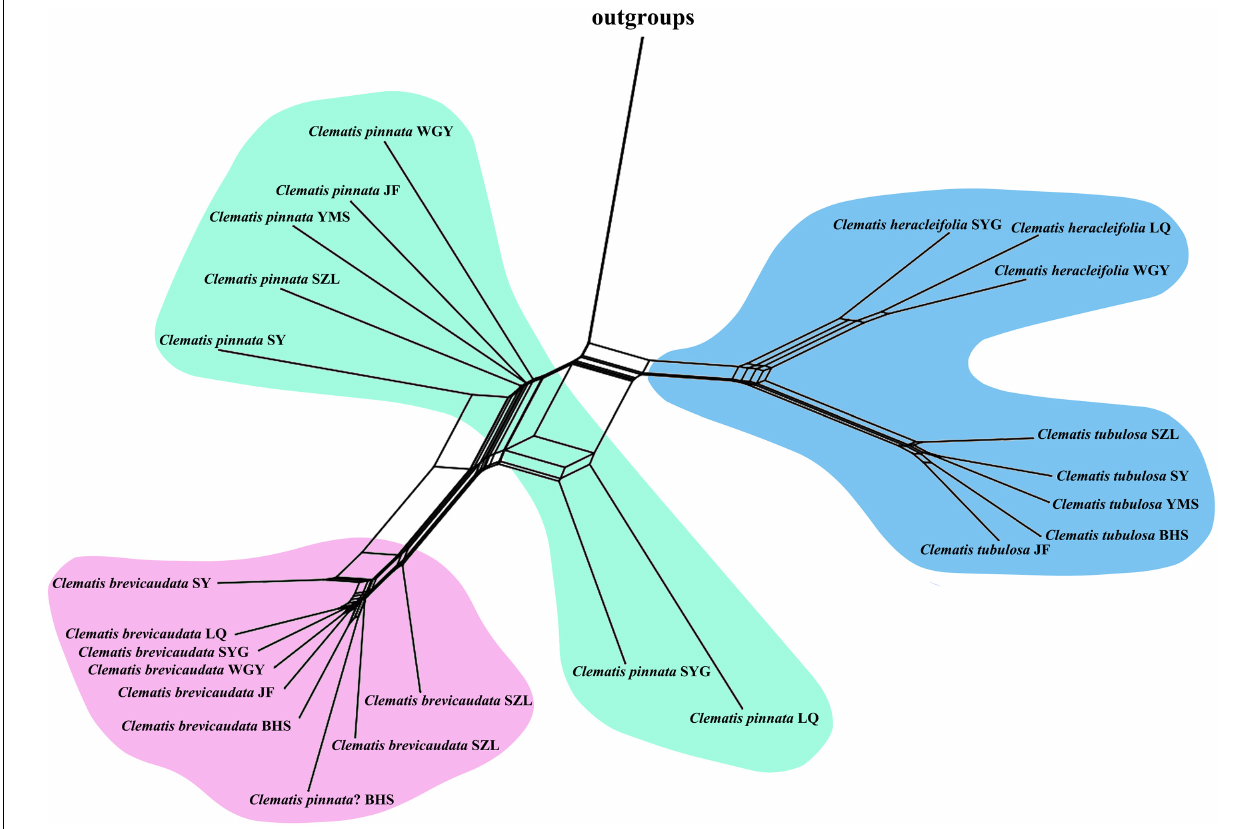
FIGURE 3 | Molecular phylogenetic network among Clematis pinnata and its putative parents from co-orthologous nuclear gene dataset (3170 SCOGs). Distance analysis was ran under K2P model (Kimura, 1980) and support values were estimated by running 1000 bootstrap replicates.